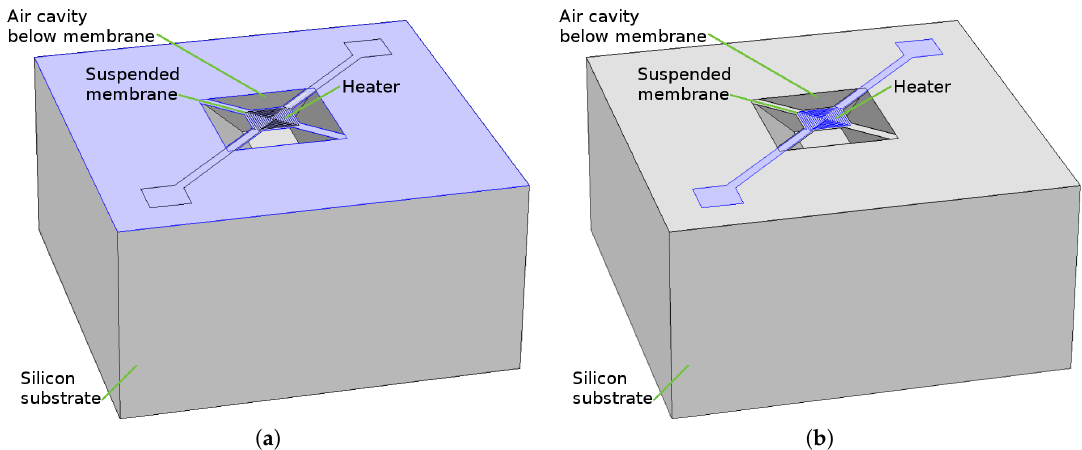
Figure 5. Simplified geometry of a device used in the electro-thermo-mechanical FEM model. In ( a ) the membrane materials are highlighted, which can include silicon nitride and silicon dioxide. In ( b ) the microheater is highlighted. The sensing layer and electrodes are not shown.